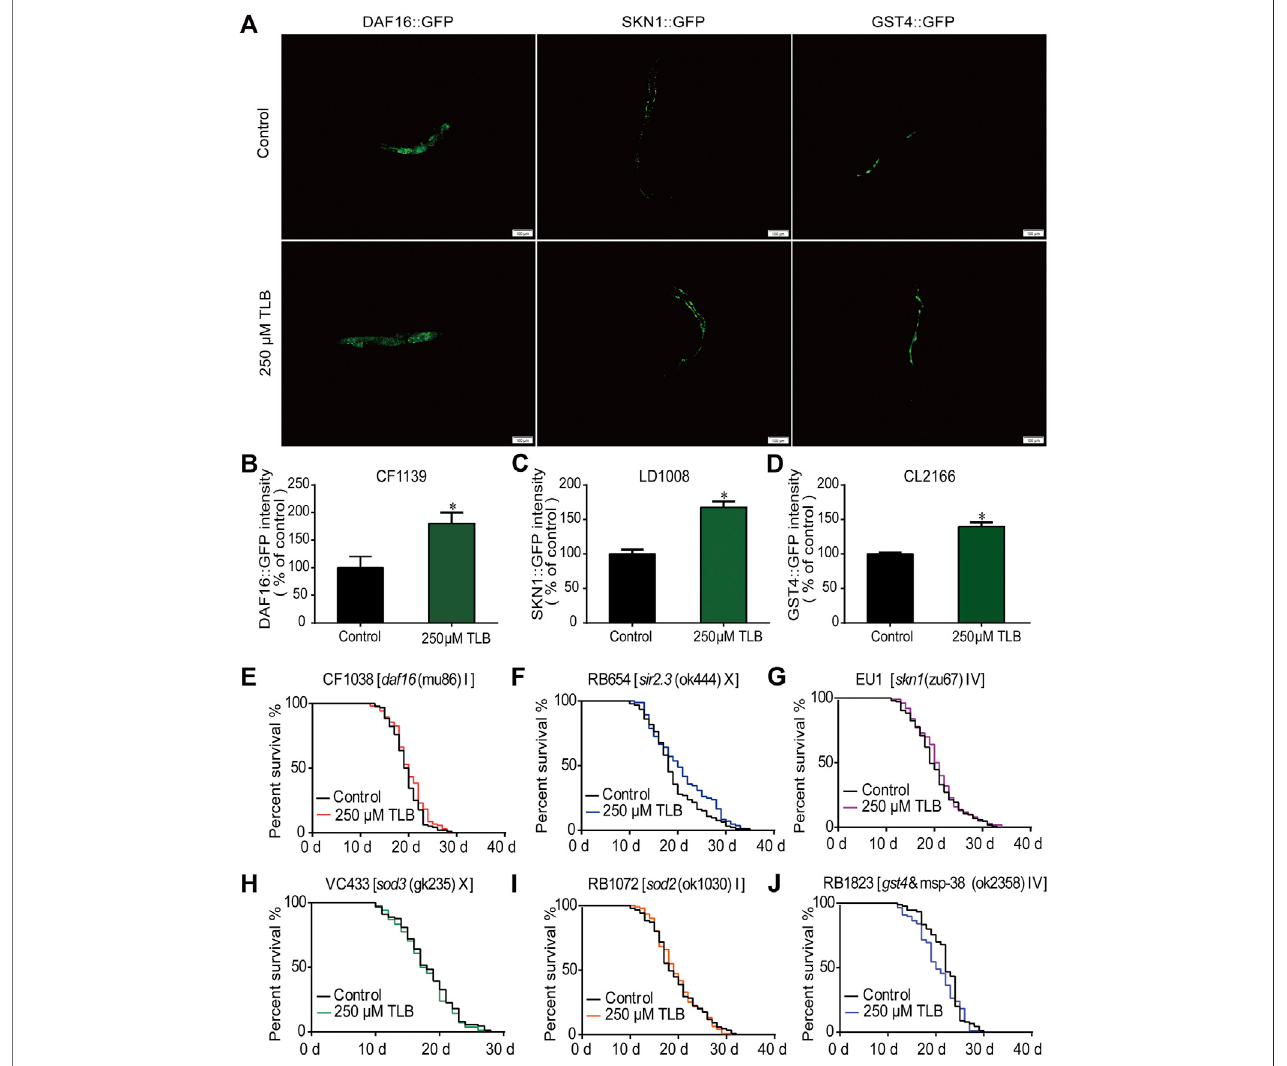
FIGURE 9 | TLB extended lifespan via SKN1/SIRT3/DAF16 signaling pathway. Wild type or mutant type C. elegans were treated with or without 250 μ M TLB for 72 h. (A) The mean pixel fl uorescence intensity of proteins GST4, SKN1, and the nuclear localization of DAF16 ( n (cid:2) 20). The fl uorescence of transgenic C . elegans were quanti fi ed using the Image Pro Plus 6.0 software. Magni fi cation, 100 × scale bar, 100 μ m (B – D) The quantization of levels of DAF16, SKN1 and GST4 (n (cid:2) 20). All age- synchronizedstrainsweretransferredtoNGMplateswithorwithout250 μ MTLBat20 ° C.Survivalcurvesof (E) daf16 (mu86)( n (cid:2) 96 – 104), (F) sir2.3 (ok444)X( n (cid:2) 84 – 93), (G) skn1 (zu67)IV( n (cid:2) 100 – 103), (H) sod3 (gk235)X( n (cid:2) 83 – 89), (I) sod2 (ok1030)( n (cid:2) 85 – 91), (J) gst4 &msp-38(ok2358)IV( n (cid:2) 88 – 90).Datawerepresentedasmean ± SEM. * p < 0.05 vs. non-TLB treated